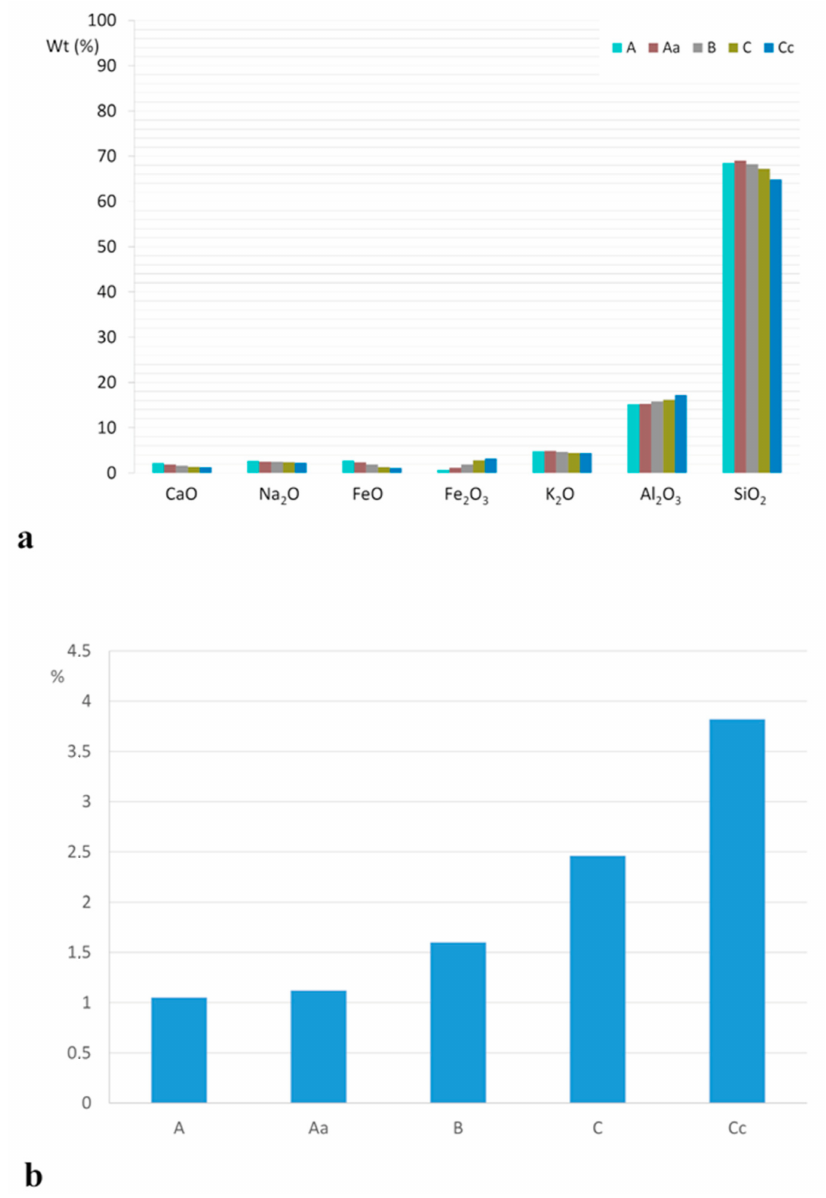
Figure 8. Variation of the concentration of some major elements ( a ) and of the LOI (loss on ignition) ( b ) in relation to the increase in in the degree of alteration (types A, Aa, B, C, and Cc). Table 3. Chemical weathering indexes